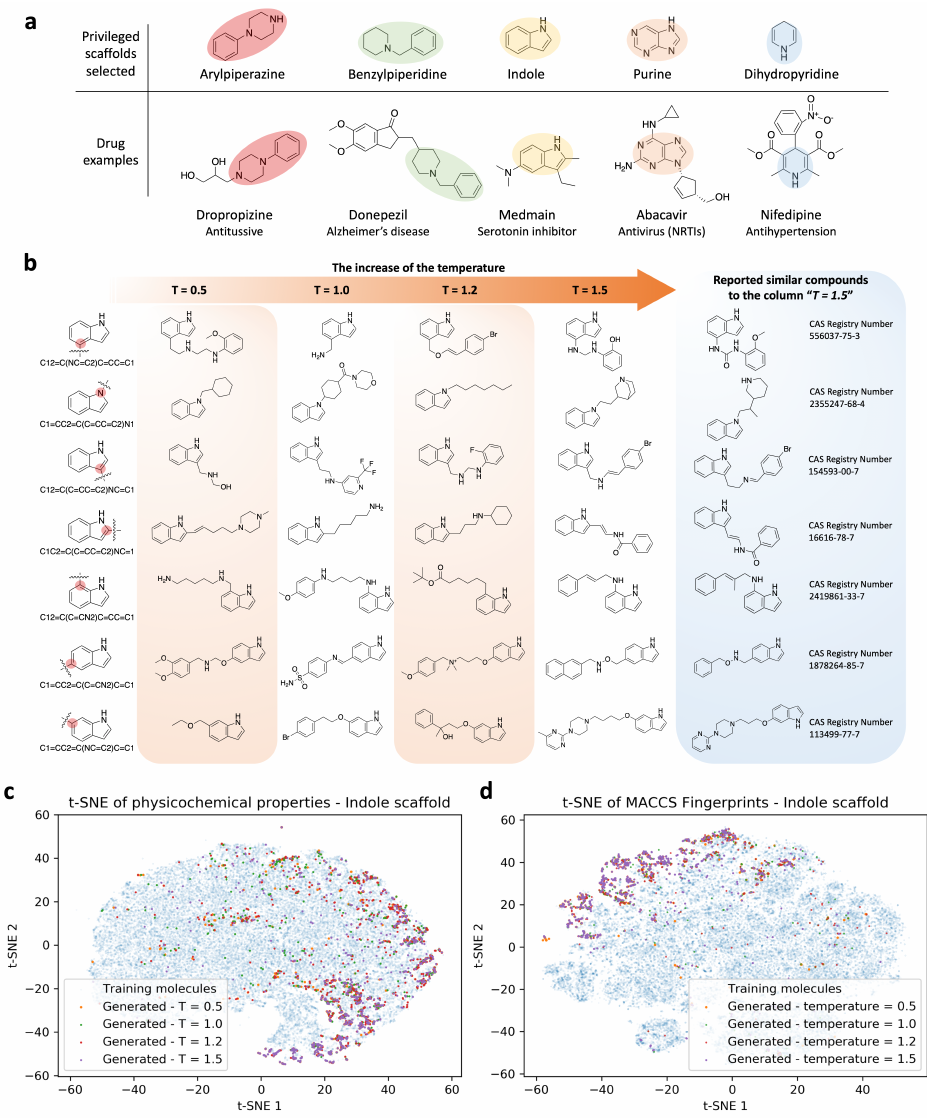
Figure 3. Privileged scaffolds and sampling examples of g-DeepMGM on indole. ( a ) Privileged scaffolds and the illustrated drugs that are derived from them. ( b ) Randomly selected sampling outcome for